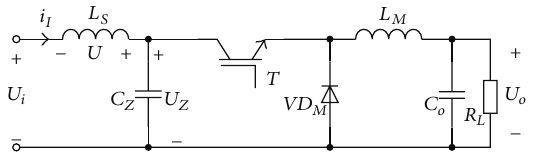
Figure 8: The conventional Buck converter topological